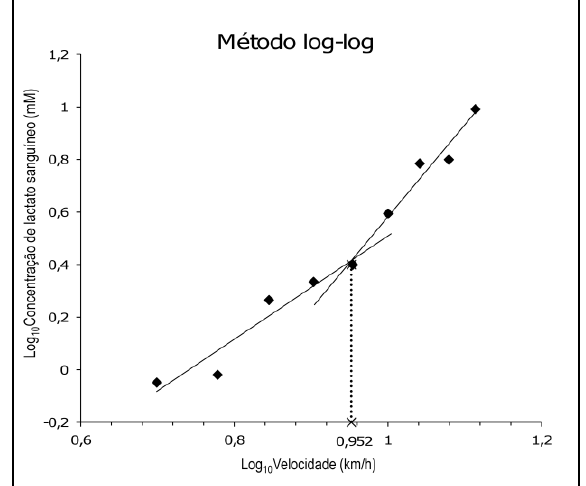
Figura 2. Velocidade no limiar de lactato determinada pelo método log-log (vLL exemplo (com os mesmos dados da Figura 1) a vLL é 10 0,952 = 8,95 log-log